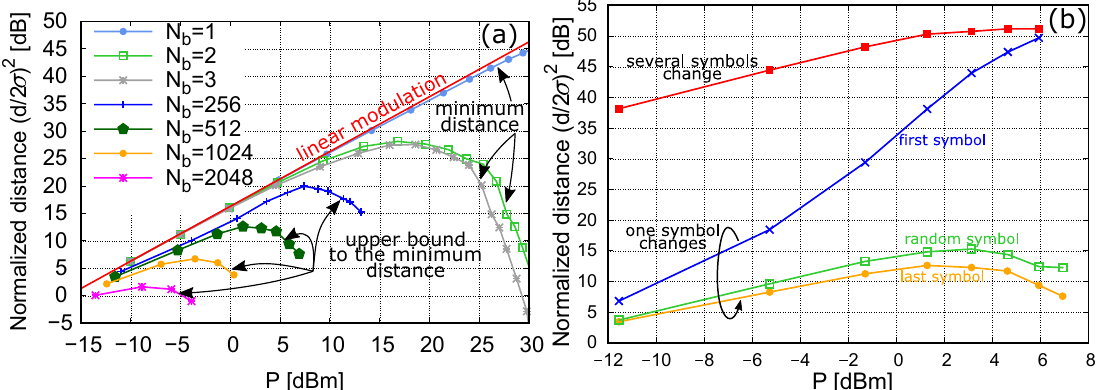
Figure 2. Nonlinear inverse synthesis (NIS) modulation ( a ) Normalized (upper bound to the) squared minimum distance between transmitted NFDM waveforms. ( b ) Normalized squared minimum distance obtained after several realizations changing a different set of